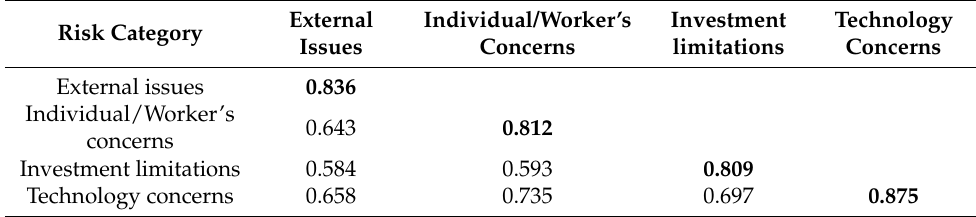
Table 6. Fornell–Larcker criterion test results.